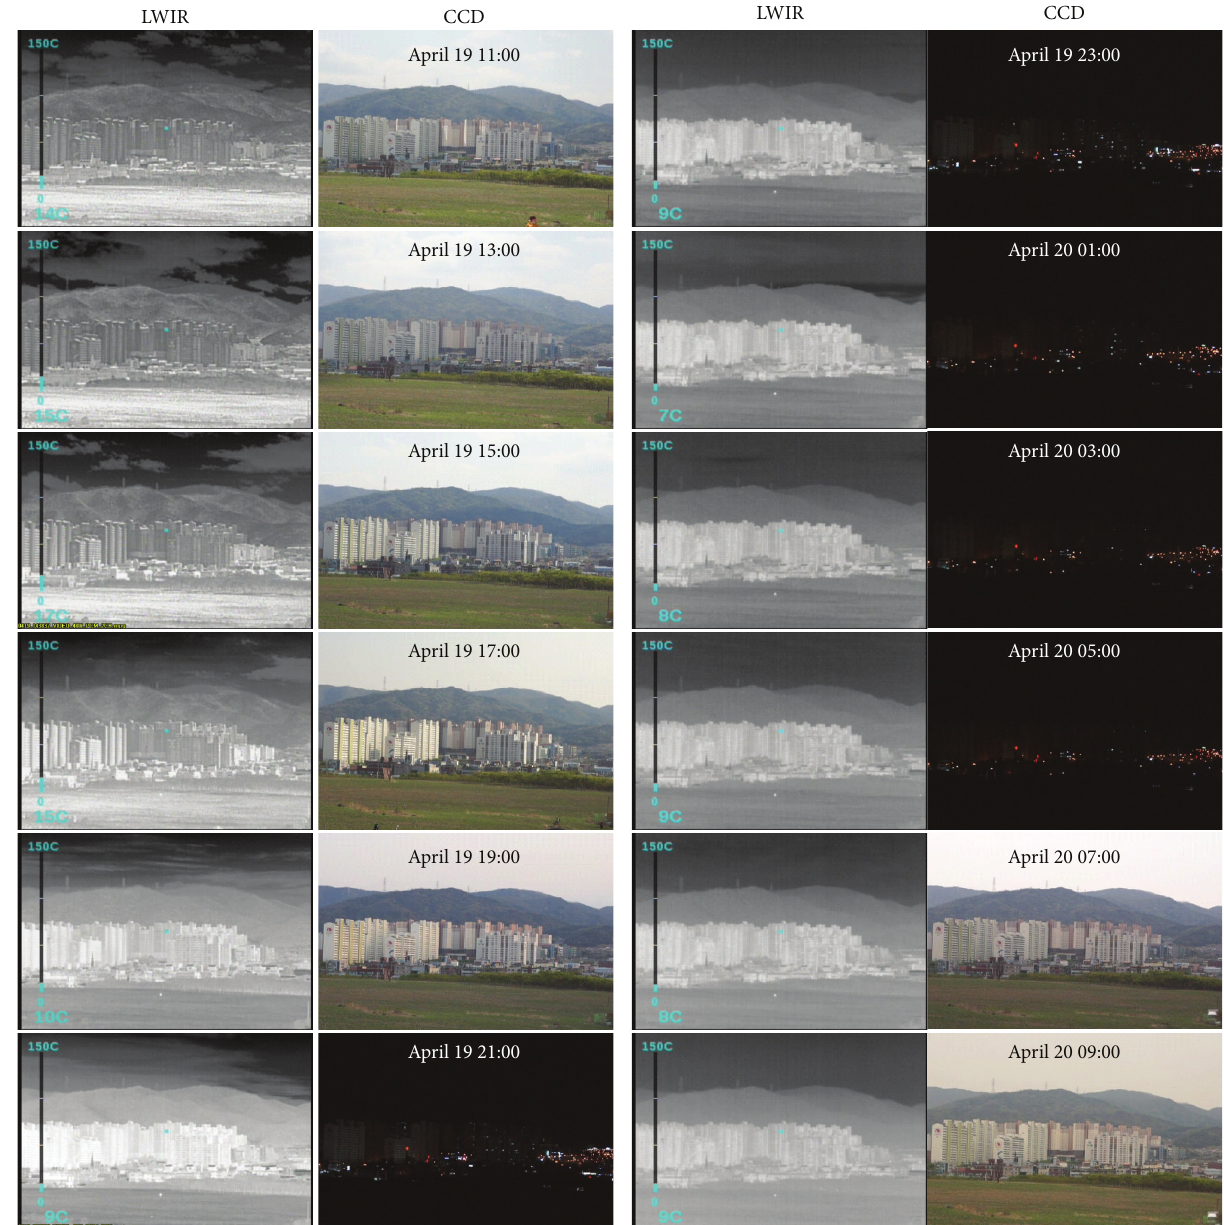
Figure 9: Partial examples of the acquired LWIR and CCD images over 24-hour period in